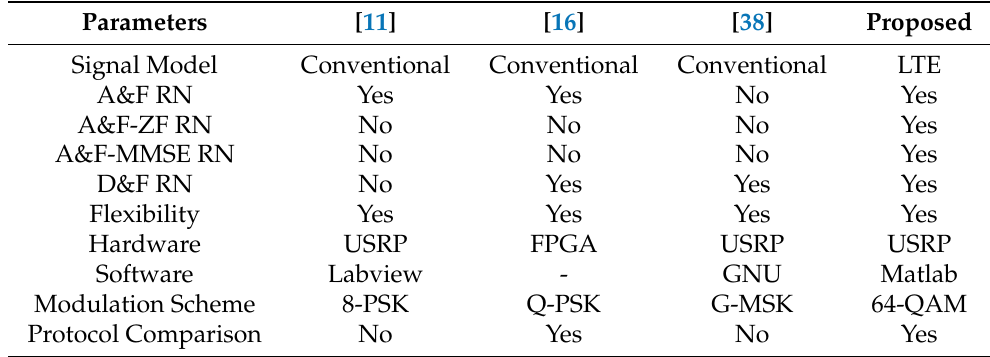
Table 3. A comparison survey with previous